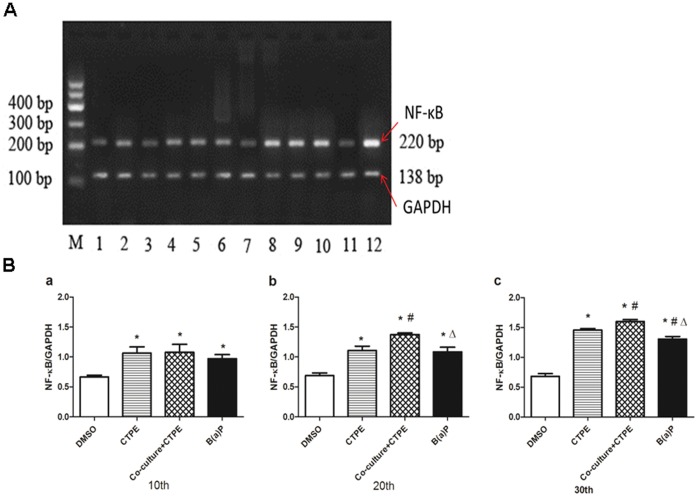
The gene levels of NF-κB in the BEAS-2B cells at passages 10, 20 and 30.(A) NF-κB mRNA of BEAS-2B cells in four groups on agarose gel. M:marker;1–4 lanes: 10th B(a)P, 10th CTPE, 10th DMSO, 10th Co-culture+CTPE; 5–8 lanes: 20th B(a)P, 20th CTPE, 20th DMSO, 20th Co-culture+CTPE; 9–12 lanes: 30th B(a)P, 30th CTPE, 30th DMSO, 30th Co-culture+CTPE. (B) Quantitative comparison of NF-κB mRNA. The level of NF-κB mRNA in Co-culture/CTPE group started to increase at passage 10, which was higher than that of CTPE or B(a)P at passage 20, and kept the highest level at passage 30.(n = 6, *: vs DMSO, P<0.05; #: vs CTPE, P<0.05; Δ:vs Co-culture+CTPE, P<0.05). The data was from two independent experiments.